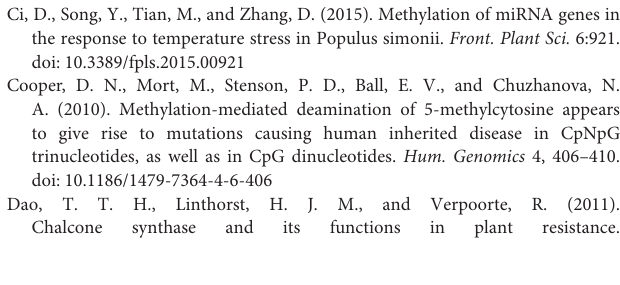
Supplementary Figure 1 | Energy landscape and nucleosome footprint. Energy level (kcal/mol nucleotide) diagram of CHS2 gene and predicted nucleosome (NS) location upon methylation. Blue line and bars, control DNA and NS; red line and bars, methylated DNA and NS. Green bars indicate exons and yellow CpG island. Also the positions of -CCGG- motifs affected by methylation (red) and not affected (blue) are included. The approximate locations of restriction sites of PvuI and AatII enzymes for DNA accessibility for restriction analysis are marked as purple lines. Supplementary Figure 2 | DNA accessibility for restriction. DNA from nontransgenic (Linola) and GM flax (W.92) lines with stable modulation of CHS gene expression) treated with restriction enzymes was followed by real-time PCR. The level of products defines DNA accessibility for restriction. The Linola flax was set as 1 (control) for each restriction enzyme. Supplementary Figure 3 | Original image of PCR products separated in gel electrophoresis presented in Figure 2. Upper row, actin; lower row, transgene. Order of samples in each row: marker, control, GM-CHS: 1, 103, 107, 115, 118, 119, 128, 135. The legend on the left presents the size of the bands from the molecular weight marker. The size of PCR products is presented on the right. Table S1 | Sequences of designed ODNs and their parameters (length, %GC, location). Table S2 | Sequences of primers used for real-time PCR